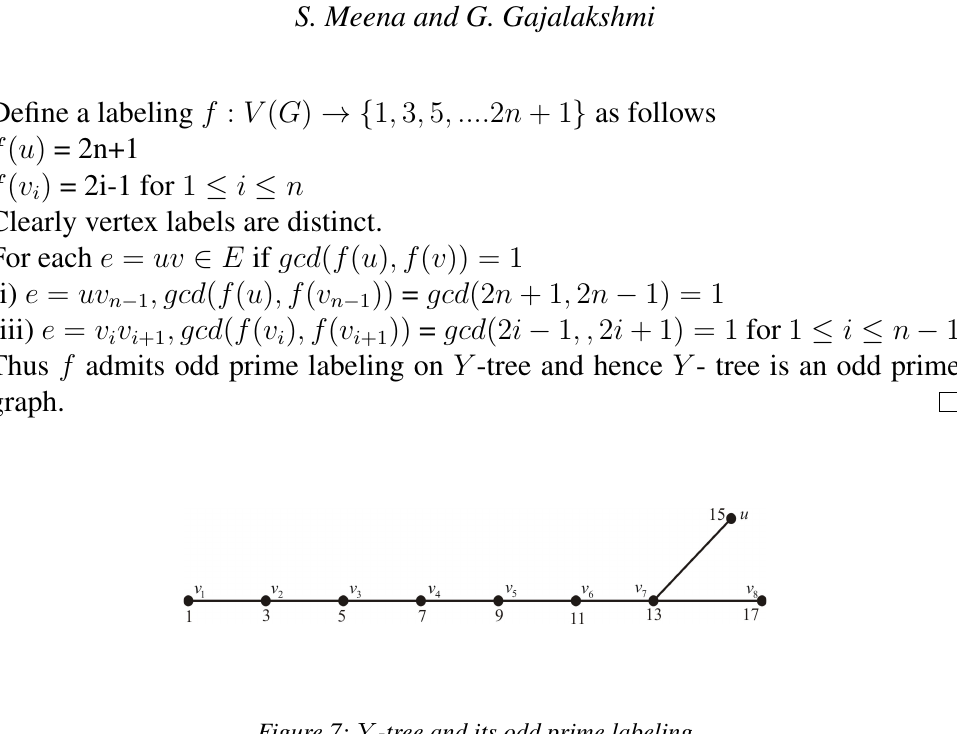
Figure 7: Y -tree and its odd prime